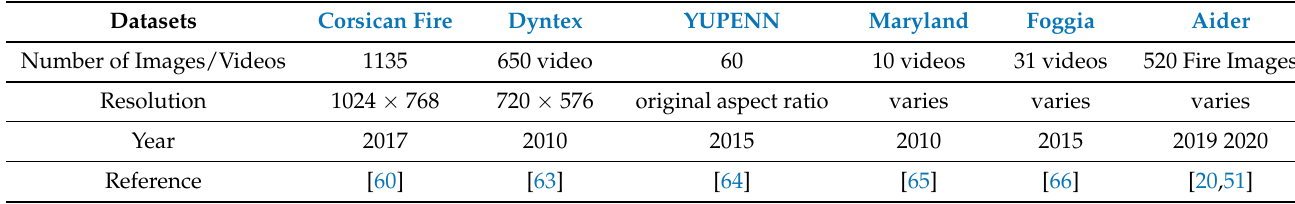
Table 3. Fire Detection